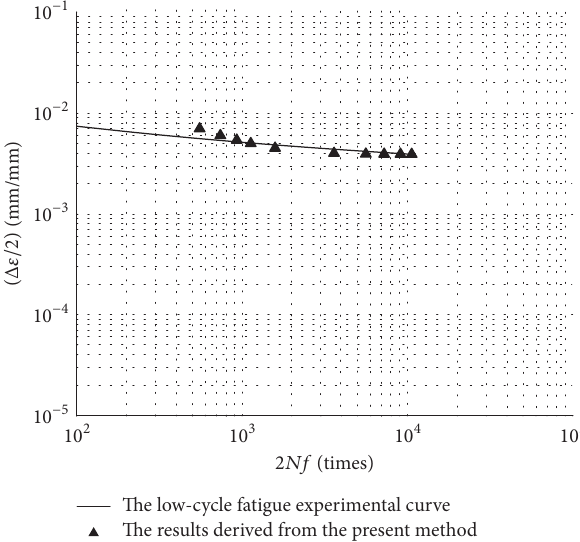
Figure7:ComparisonbetweenFEresultsandexperimentaldatafor material 35Cr2Ni4MoA.